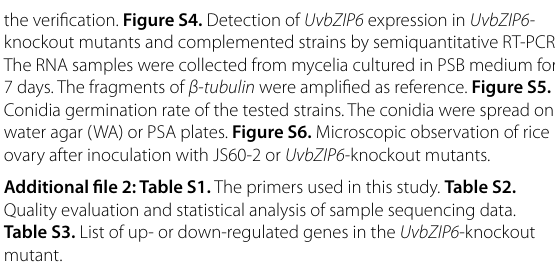
Table S3. List of up- or down-regulated genes in the UvbZIP6 -knockout